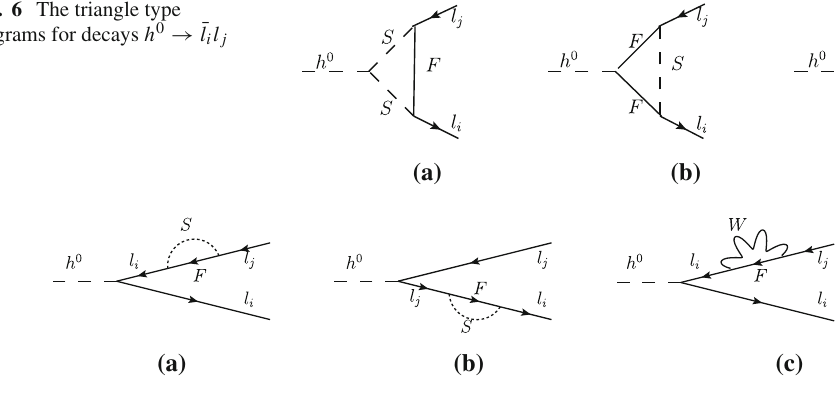
Fig. 7 The self-energy type diagrams for decays h 0 → ¯ l i l j